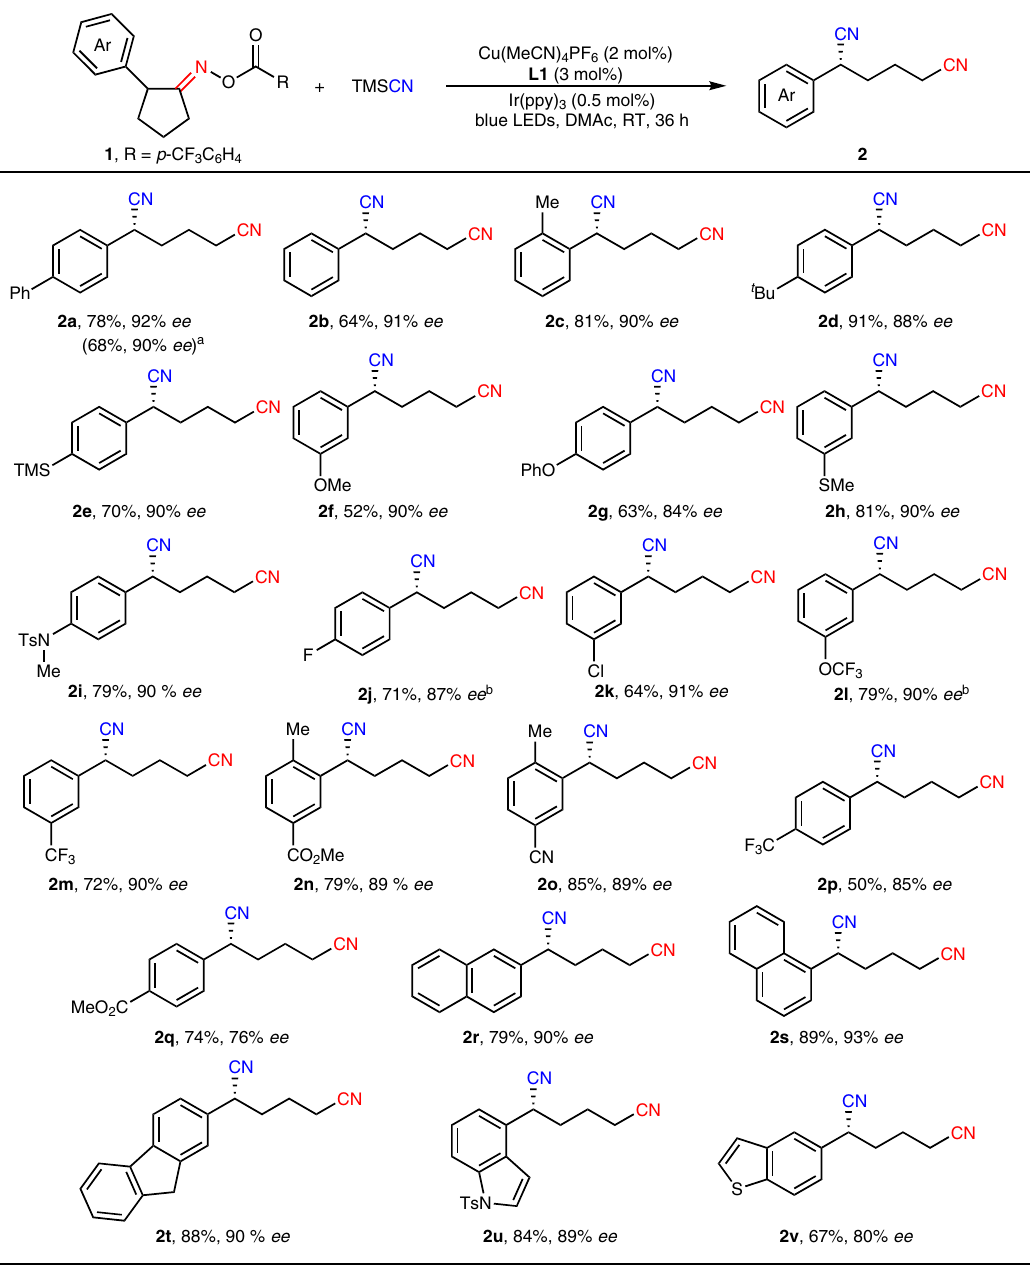
Fig. 2 Substrate scope of the cyclopentanone oxime esters 1 . Reaction conditions: 1 (0.10mmol), TMSCN (1.5 equiv), Cu(MeCN) 4 PF 6 (2 mol%), L1 (3 mol %), Ir(ppy) 3 (0.5 mol%) in DMAc (1.0 mL) at RT for 36 h under the irradiation of 5 W blue LEDs. a 1.0 mmol scale. b Cu(MeCN) 4 PF 6 (1.5 mol%), L1